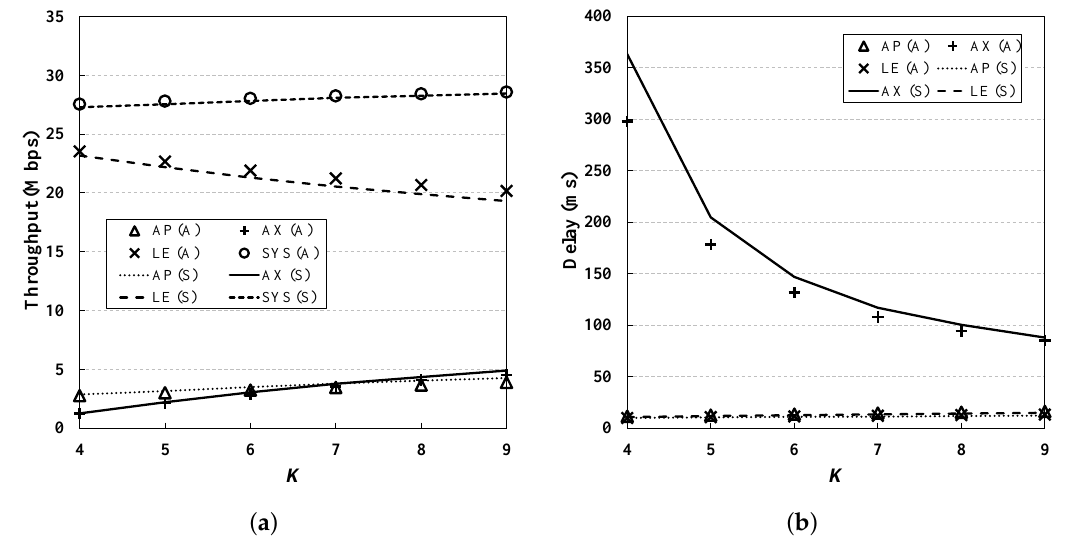
Figure 8. Performance evaluation for different values of K . Higher K values allow more AX STAs to transmit and receive concurrently, thus giving higher performance. ( a ) Throughput; ( b )